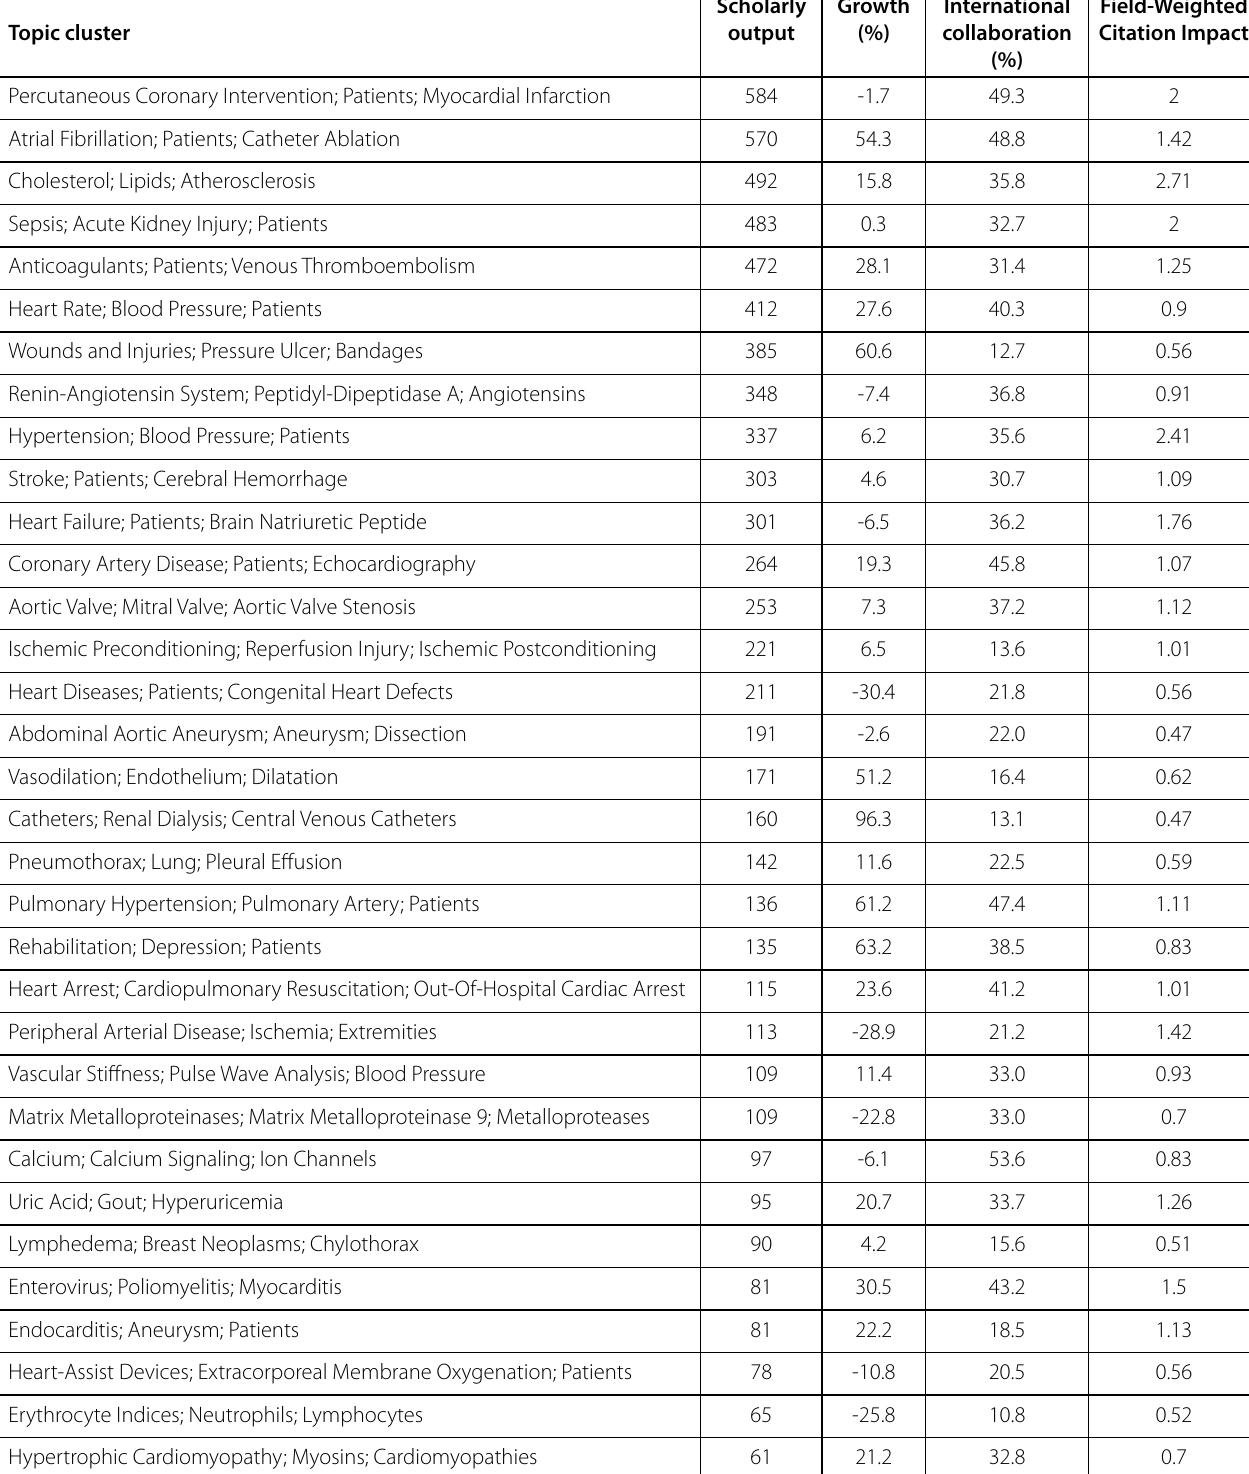
Table 1 . Topic clusters associated to the field of cardiovascular disease. Topic